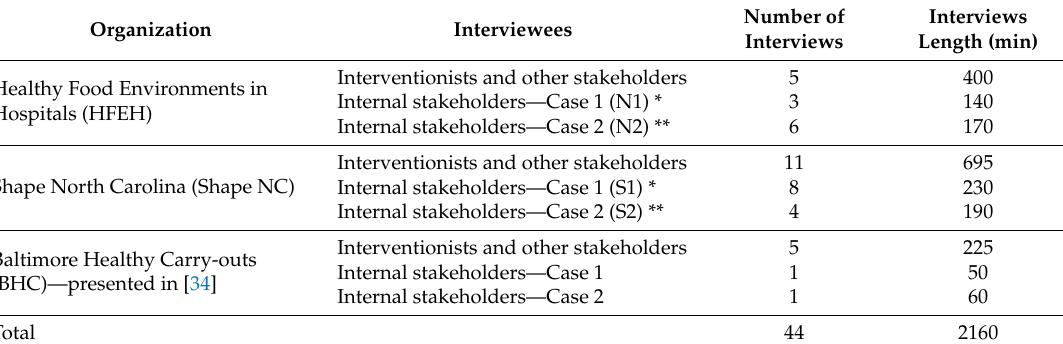
Table 1. Summary of the